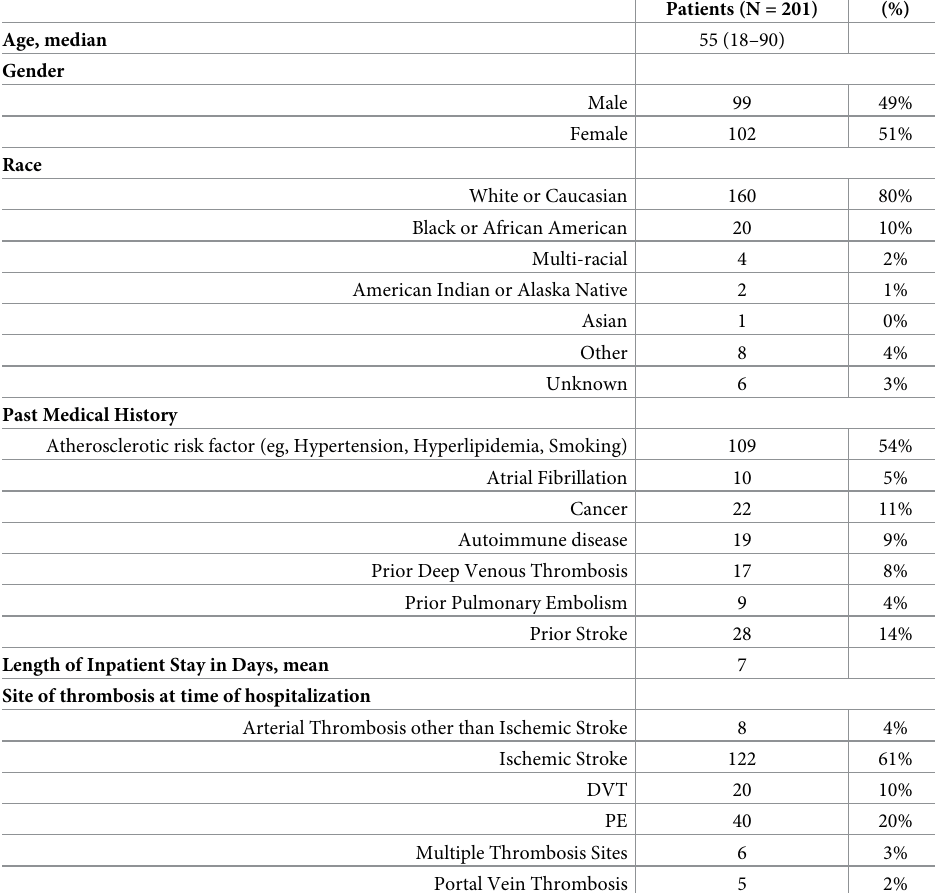
Table 1. Patient